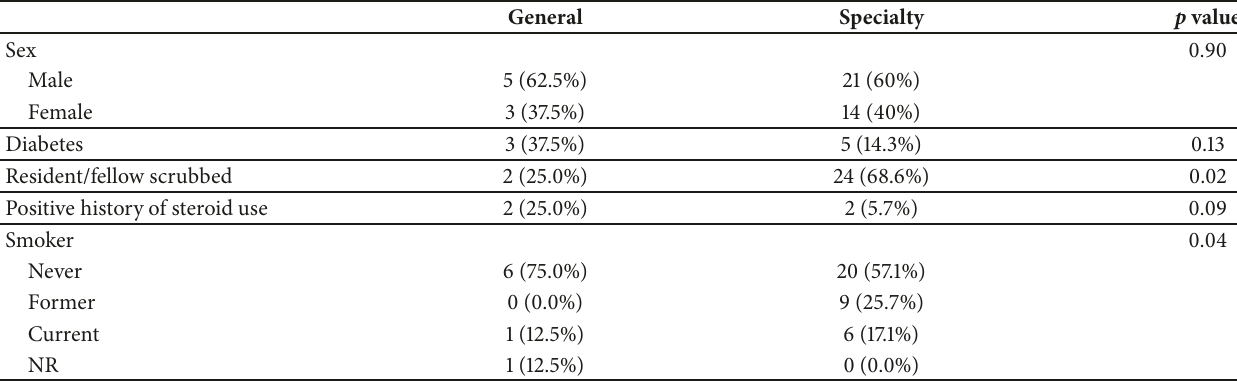
Table 5: Demographic variables at general university versus dedicated orthopaedic hospital for TKA PJIs. Demographic variables, such as BMI, sex, diabetes, whether a resident/fellow was scrubbed, positive history of steroid use, and smoking status were examined at the general